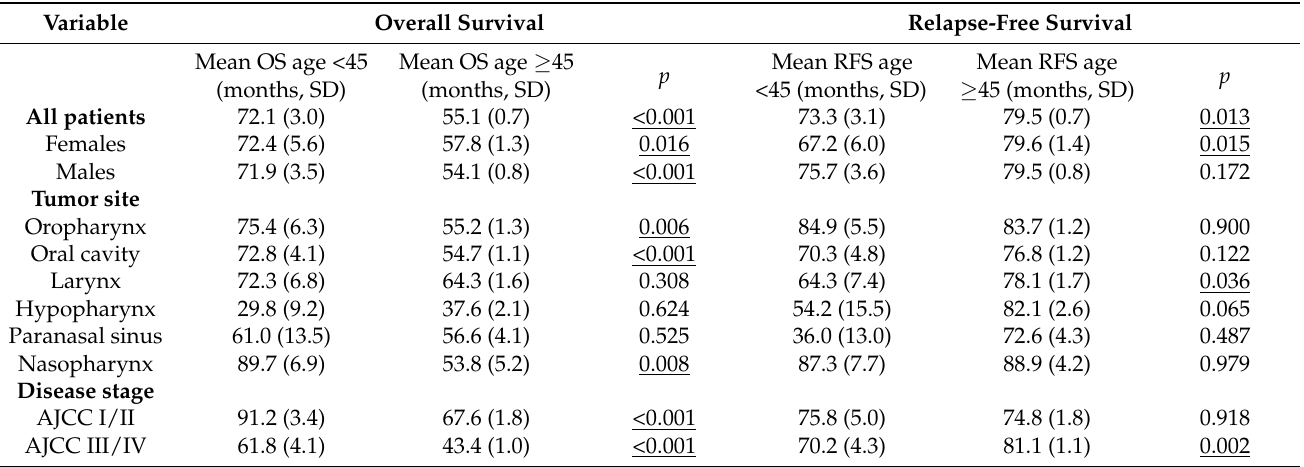
Table 2. Comparison of clinicopathologic variables associated with overall survival (OS) and relapse- free survival (RFS) in patients younger and older than 45